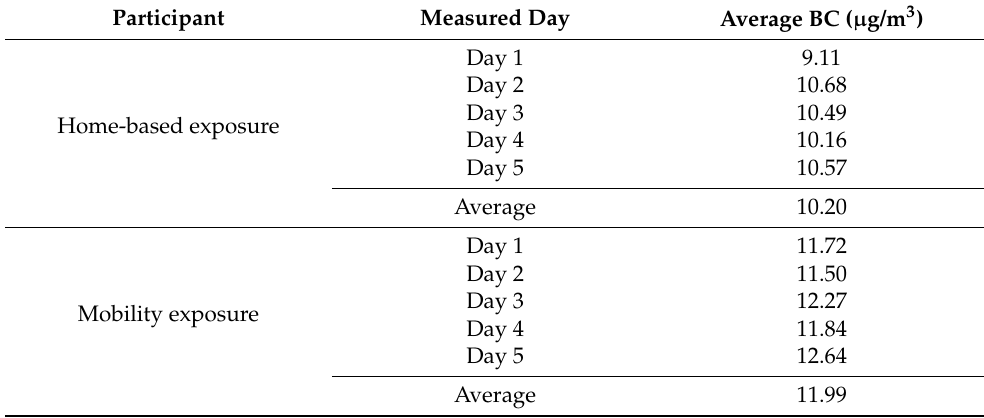
Table A1. Daily BC personal exposure concentrations for the home-based and mobility-based participant on representative